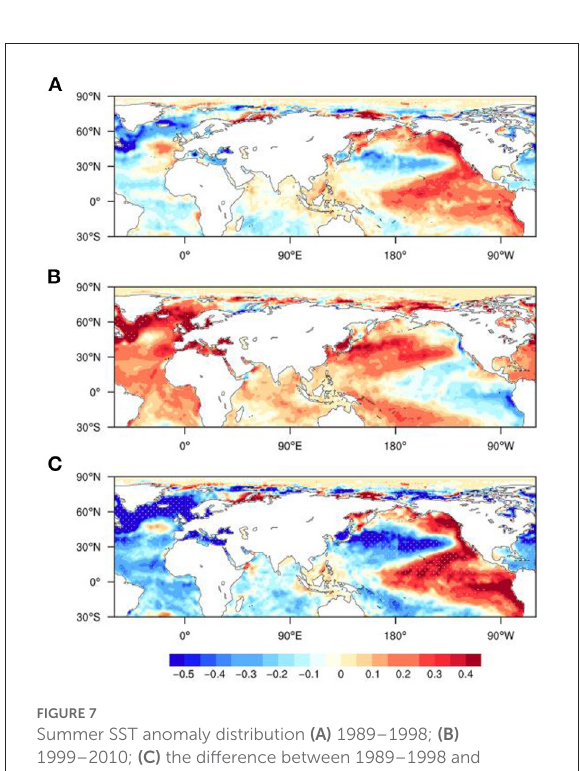
FIGURE6 Vertically integrated water vapor flux anomalies (arrows, unit: kg m − 1 s − 1 ) and water vapor flux divergence anomalies (shading, unit: 10 − 6 kg m − 2 s − 1 ) in the summer. Green dots indicate significance at the 95% confidence level (Xue et al., 2022).